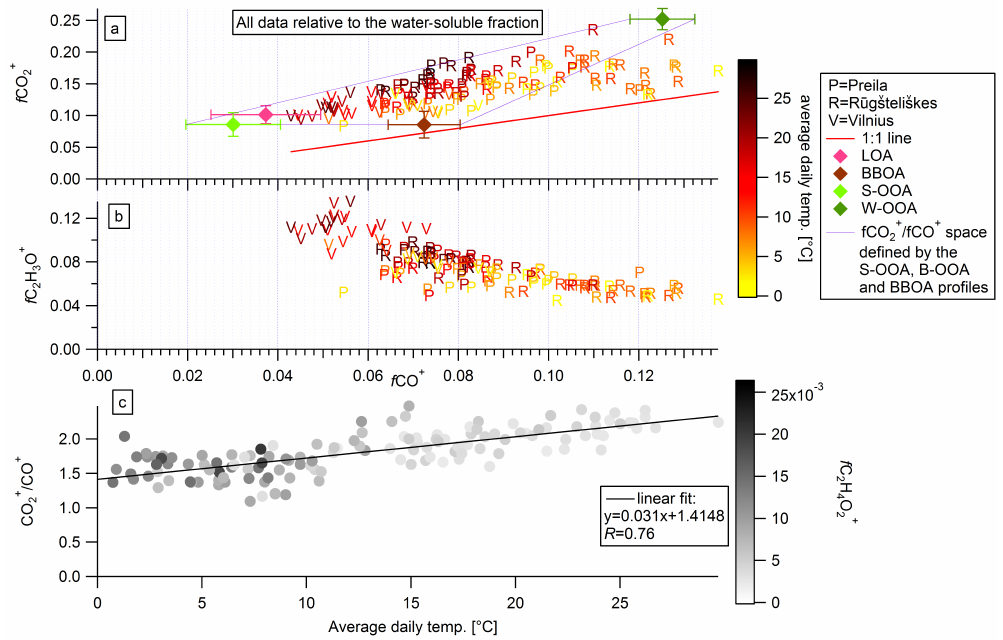
Figure 7. (a) Water-soluble f CO + vs. f CO + scatter plot. Color code denotes the average daily temperature ( ◦ C), diamonds indicate the 2 f CO + : f CO + ratio for different PMF factor profiles. The 1 : 1 line is displayed in red. Few points from R¯ugšteliškis lie outside the triangle, 2 suggesting they are not well explained by our PMF model. However, Fig. S5 displays flat residuals for R¯ugšteliškis, indicating an overall good WSOM explained variability by the model. (b) Water-soluble f C 2 H 3 O + vs. f CO + scatter plot. Color code denotes the average daily temperature ( ◦ C). (c) Scatter plot of the water-soluble CO 2 + :CO + ratio vs. average daily temperature. Grey code denotes f C 2 H 4 O +